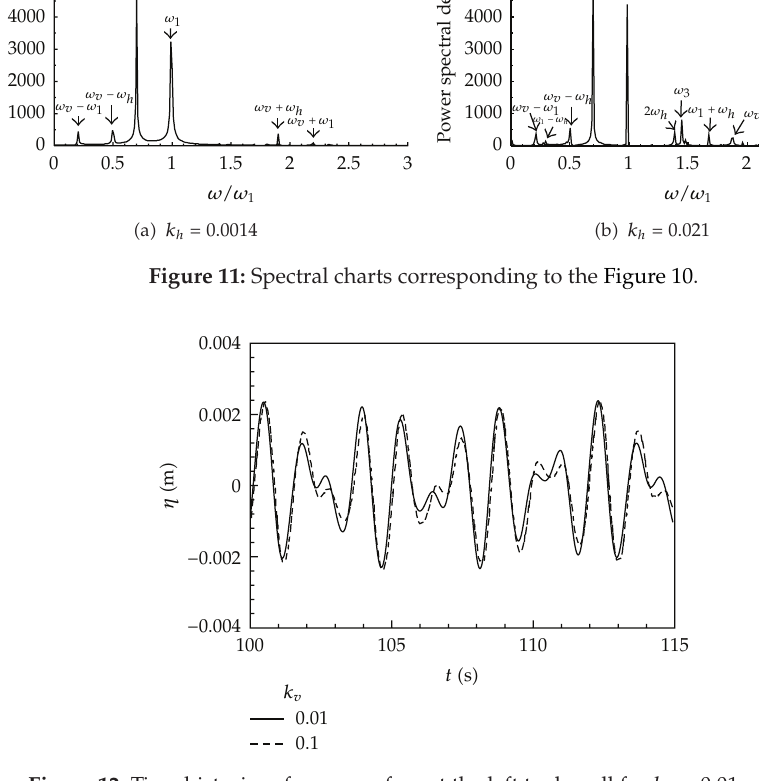
Figure 12: Time histories of wave surface at the left tank wall for k v (cid:8) 0 . 01 and